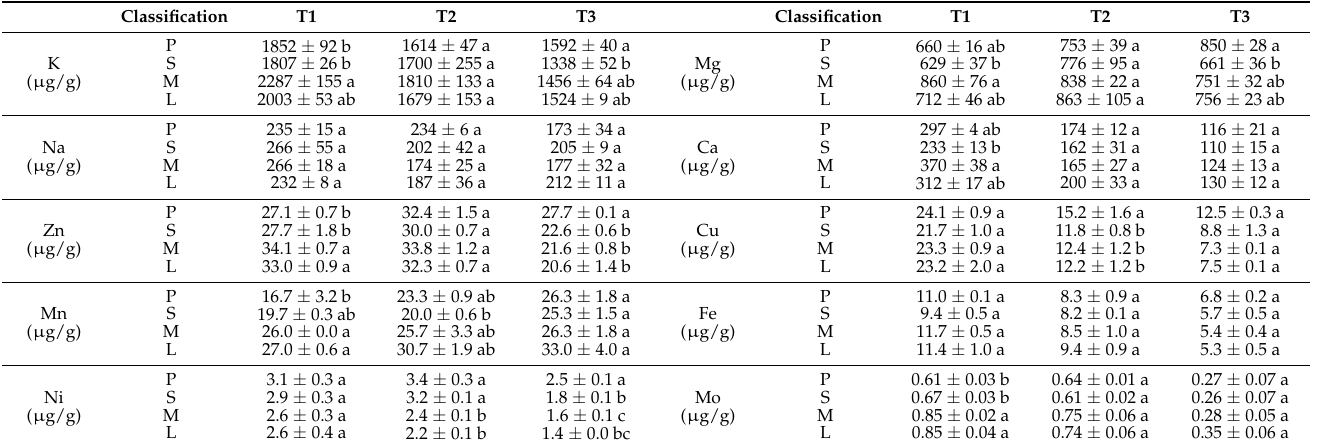
Small letters represent significant difference at the 5% level between classifications (P, S, M, L) for each treatment (T1, T2, T3). Data presented are mean ±